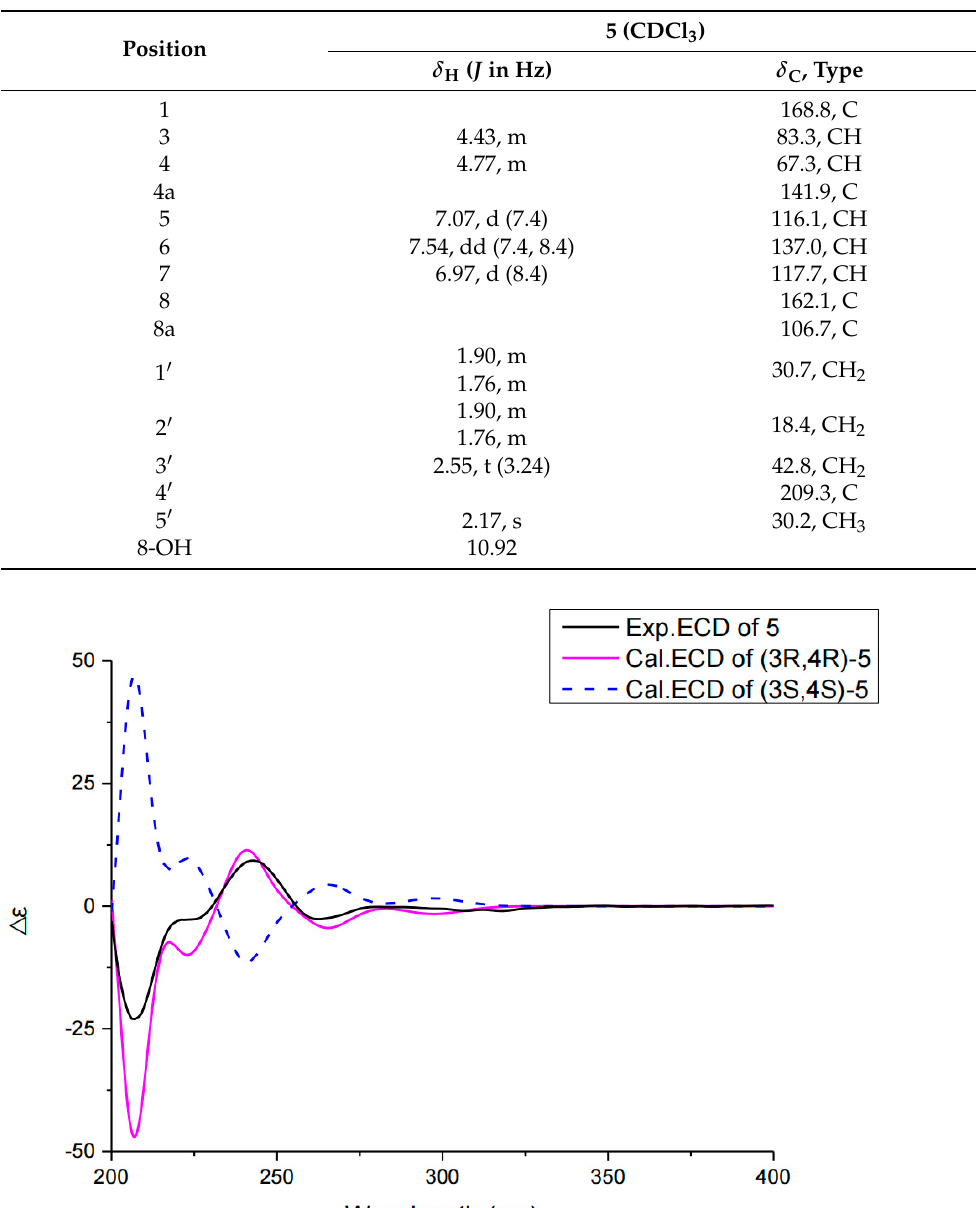
Table 2. 1 H and 13 C NMR data for compound 5 (CDCl 3 ).